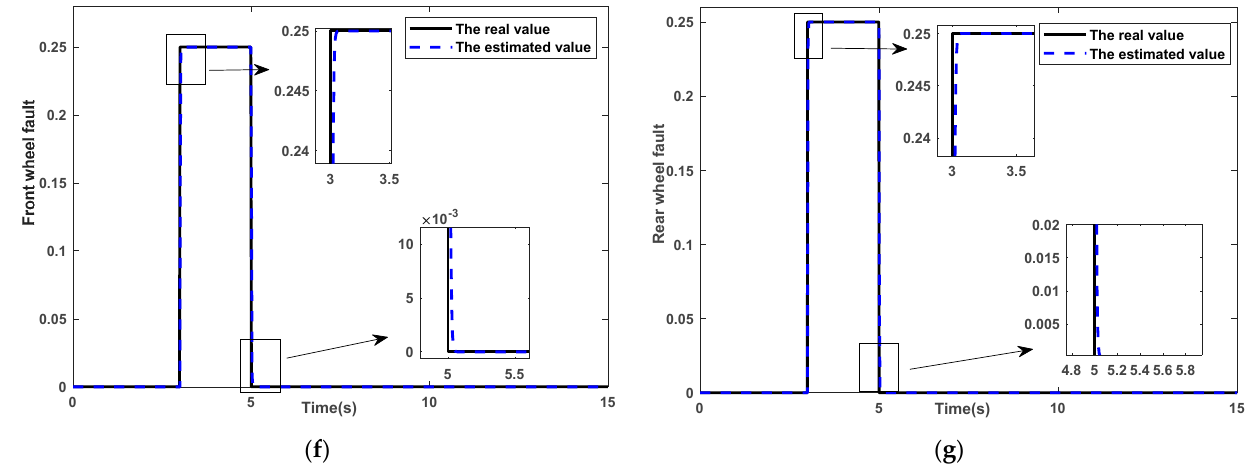
Figure 3. The response curve of the system. ( a ) The curve of front and rear wheel angle. ( b ) The curve of the yaw rate. ( c ) The curve of side slip angle. ( d ) The error curve of the yaw rate. ( e ) The error curve of side slip angle. ( f ) The curve of front wheel fault. ( g ) The curve of rear wheel fault.